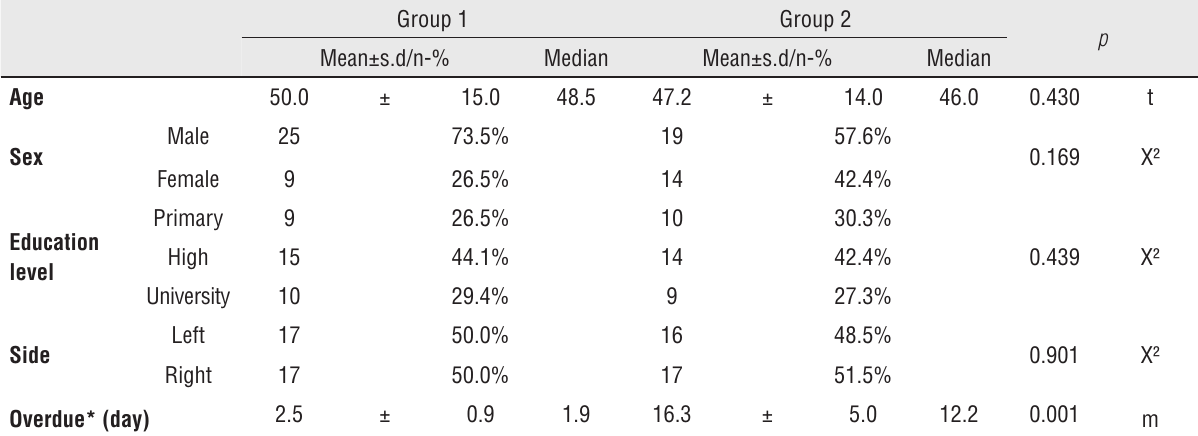
Table 2 - Results and comparison of the two